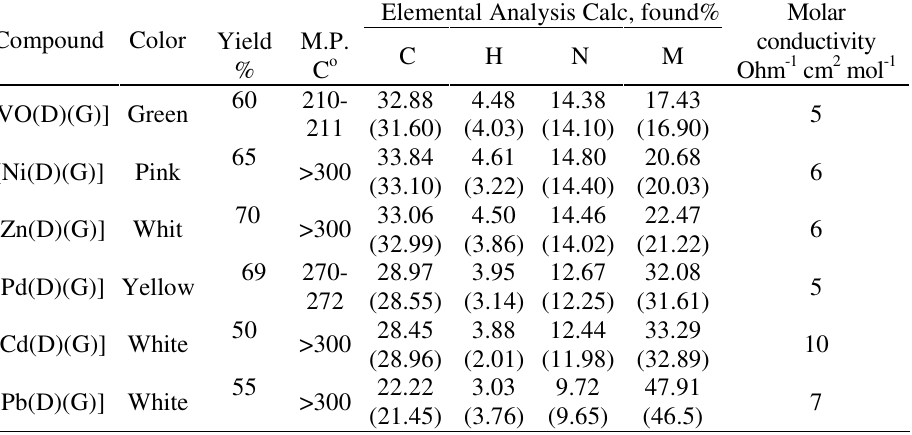
Table 1. Analytical and physical data of the prepared complexes